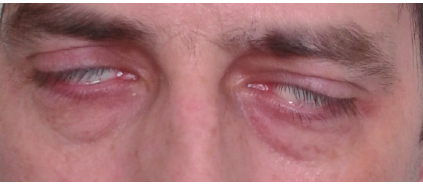
Figure 2: Bilateral facial nerve palsy, incompetence of palpebral